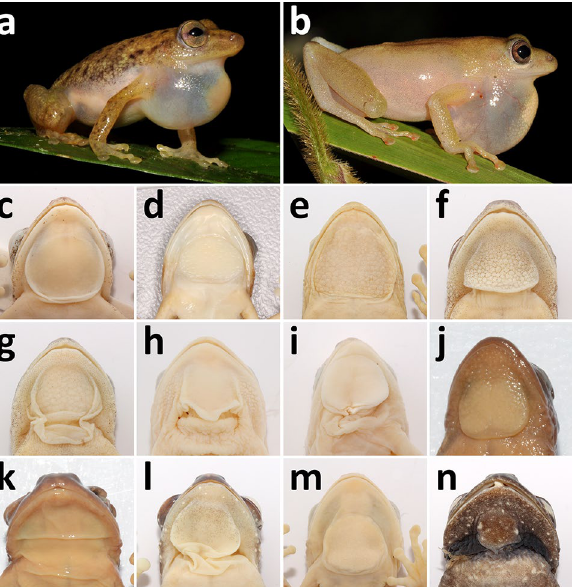
Figure 4. Gular region of selected hyperoliid taxa. ( a ) Congolius robustus gen. et comb. n. (IVB-H-CD18-255) with inflated vocal sac, ( b ) Hyperolius balfouri (IVB-H-CD15-062) with inflated vocal sac, ( c ) C. robustus gen. et comb. n. (ZMUC-R.771175), ( d ) Morerella cyanophthalma (ZMB 71588, paratype), ( e ) Cryptothylax greshoffii (NMP-P6V 76076/1), ( f ) H. balfouri (IVB-H-CD15-061), ( g ) H. cf. cinnamomeoventris (IVB-H-CD18-092), ( h ) H. phantasticus (IVB-H-CD18-203), ( i ) H. cf. adspersus (IVB-H-CD15-139), ( j ) Chrysobatrachus cupreonitens (MCZ A-64739, paratype), (k) Callixalus pictus (MCZ A-64707), ( l ) Afrixalus equatorialis (NMP-P6V